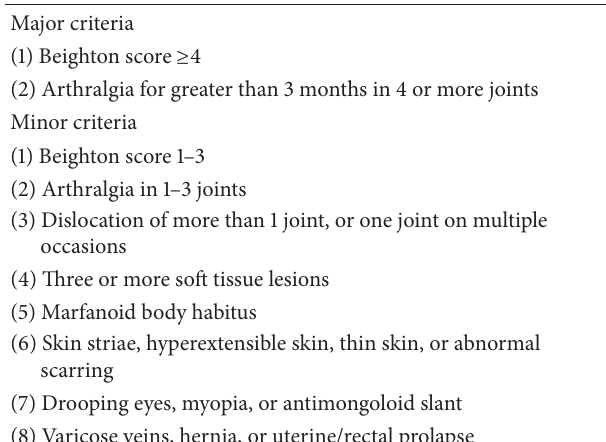
Table 1: Criteria for diagnosis of Ehlers-Danlos syndrome— hypermobility